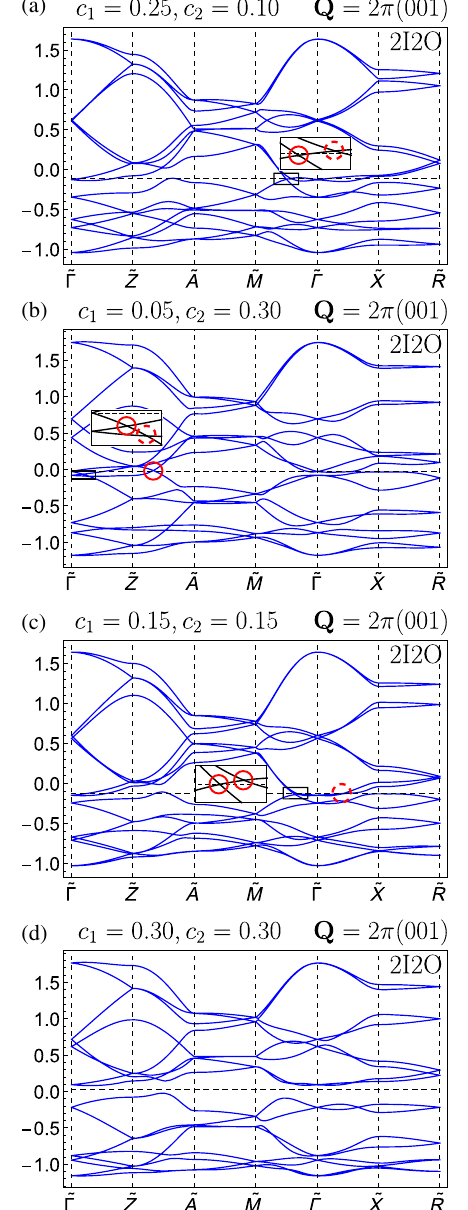
FIG. 8. The complete Ir band structure and its evolution as a function of f - d exchange c 1 and c 2 . The dashed (solid) circle marks the usual (double) Weyl node where the definition of different types of Weyl node has given in main text. A sufficient strong f - d exchange coupling wipes out Weyl nodes near the Fermi surface and opens band gaps. The energy unit is t dashed line refers to the Fermi